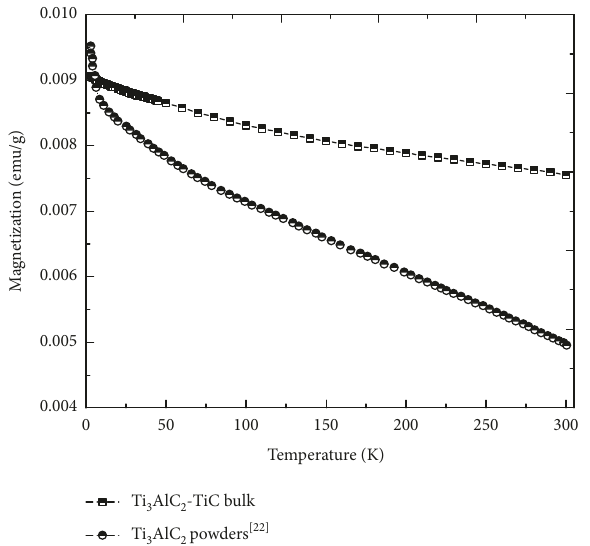
Figure 9: Temperature-dependent magnetization of Ti